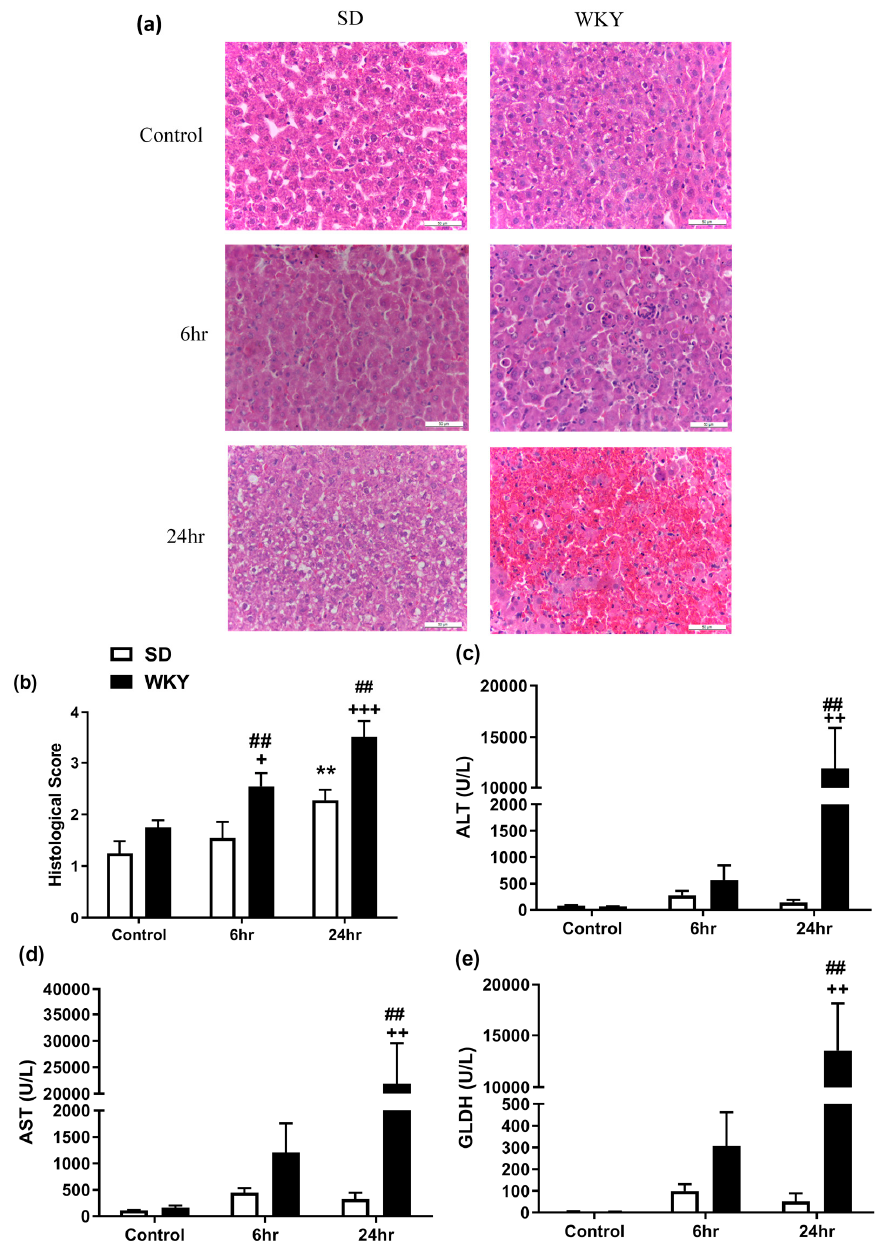
Figure 2. ( a ) Histological examination of liver from SD and WKY rats following saline (control) or LPS/GalN administration (6 and 24 h post administration) (H&E staining 400×. Bar = 50 µm). Effect of LPS/GalN on ( b ) hepatic histopathology score and plasma levels of ( c ) ALT ( d ) AST and ( e ) GLDH. Data expressed as mean ± SEM ( n = 6–8). * p < 0.05; ** p < 0.01 vs. SD saline; ++ p < 0.01 +++ p < 0.001 vs. WKY saline; ## p < 0.01 vs. SD counterpart.